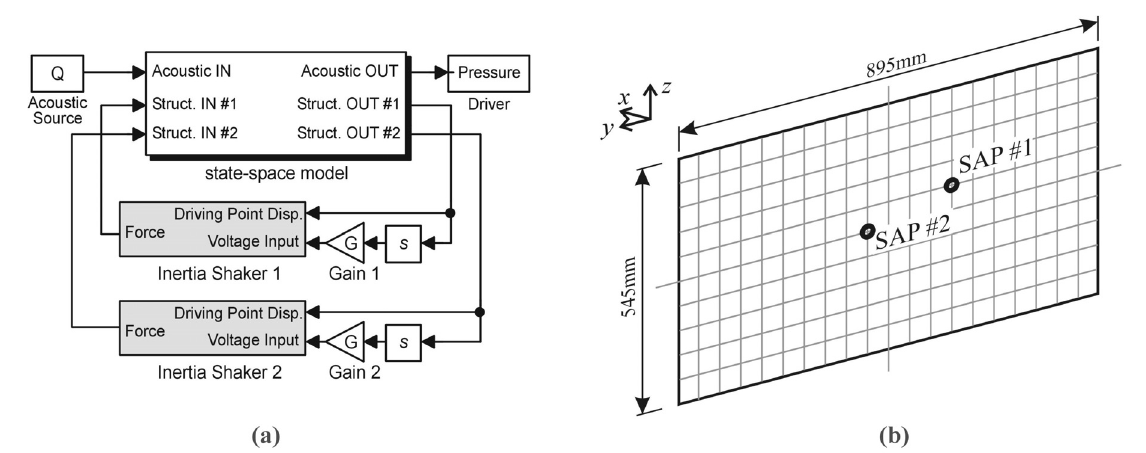
Fig. 13. 2 SAPs ASAC: (a) block diagram and (b) SAP positions on the firewall.